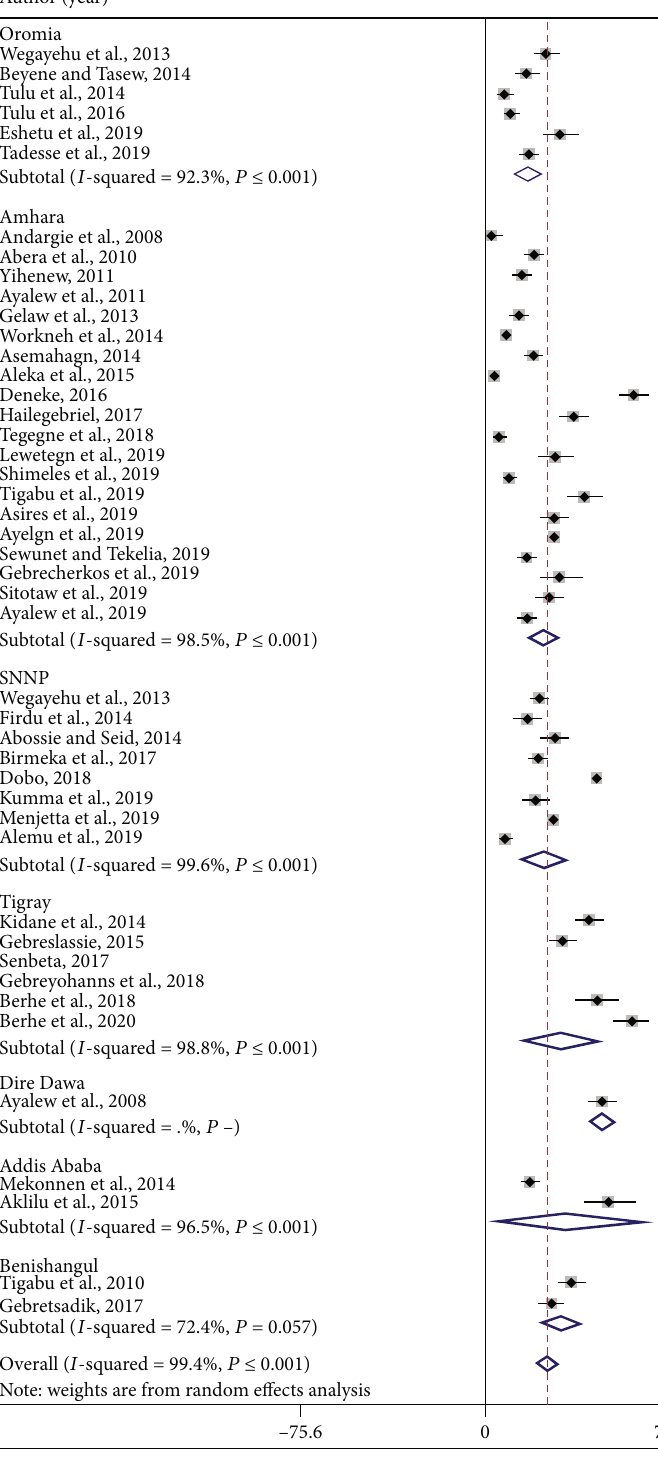
Figure 2: Pooled prevalence of HIPPIs in Ethiopia including the regional level. Each square represents the e ff ect size (ES) of individual studies, and the horizontal line represents the 95% CI. The diamond indicates the pooled e ff ect, and the vertical dash lines indicate the overall